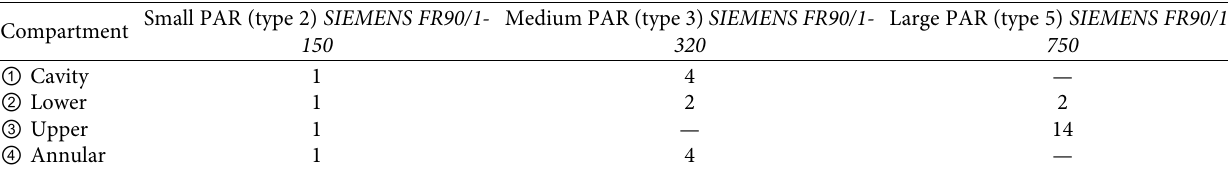
Table 3: PAR type, number, and location [26].